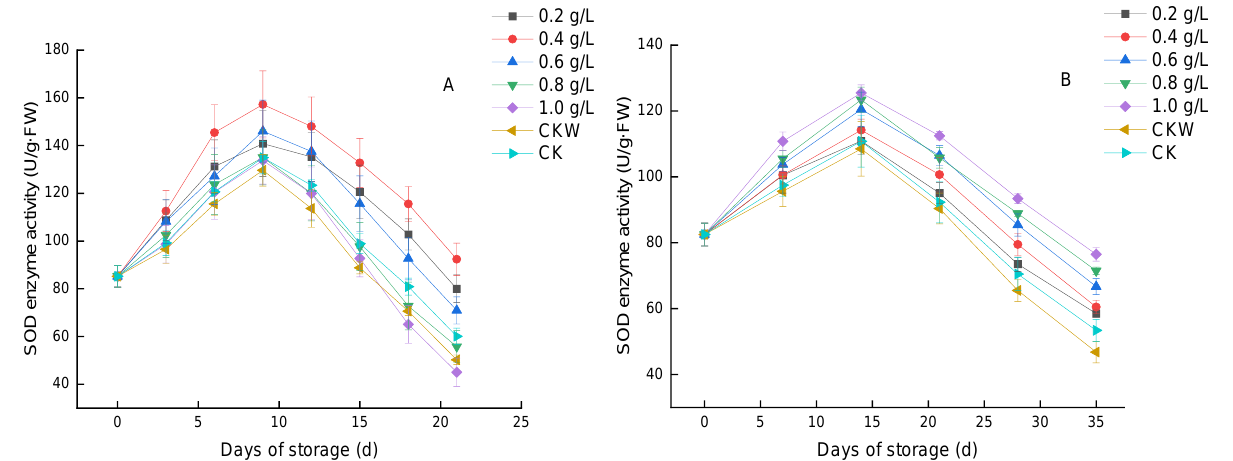
Figure 8. Effects of different Lycium barbarum leaf extract concentrations on SOD activities in cherry tomatoes at 20 °C ( A ) and 5 °C ( B ).